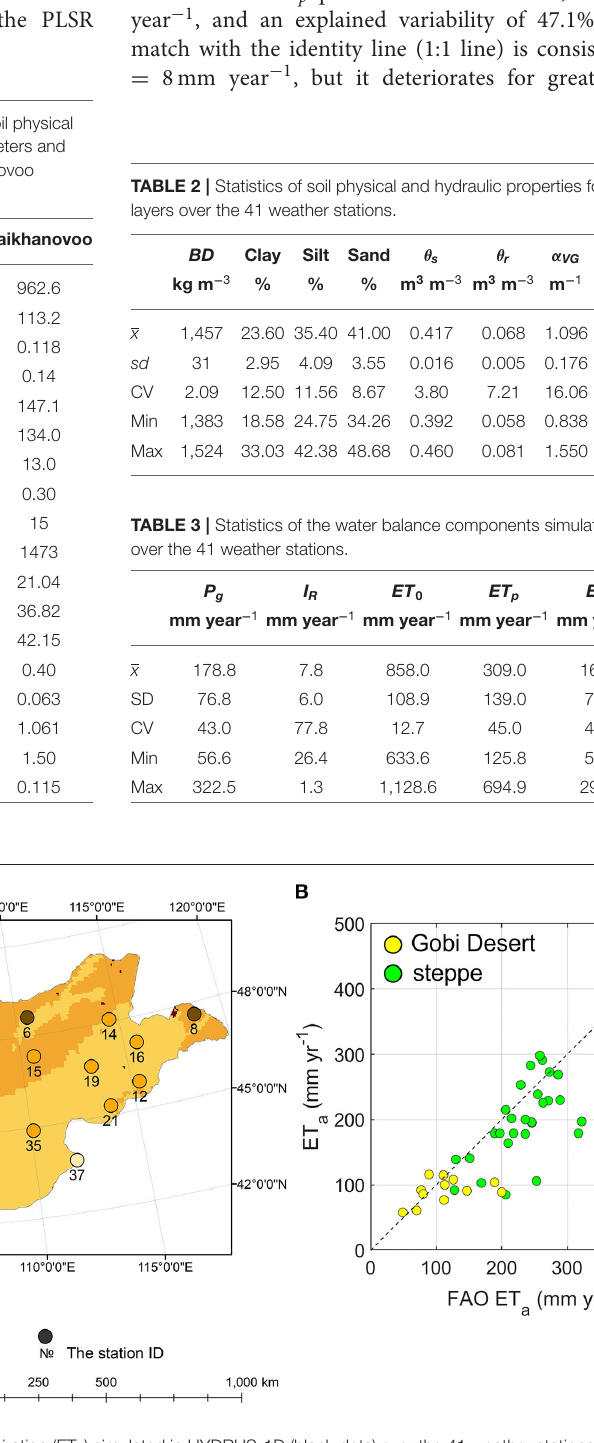
Frontiers in Water |